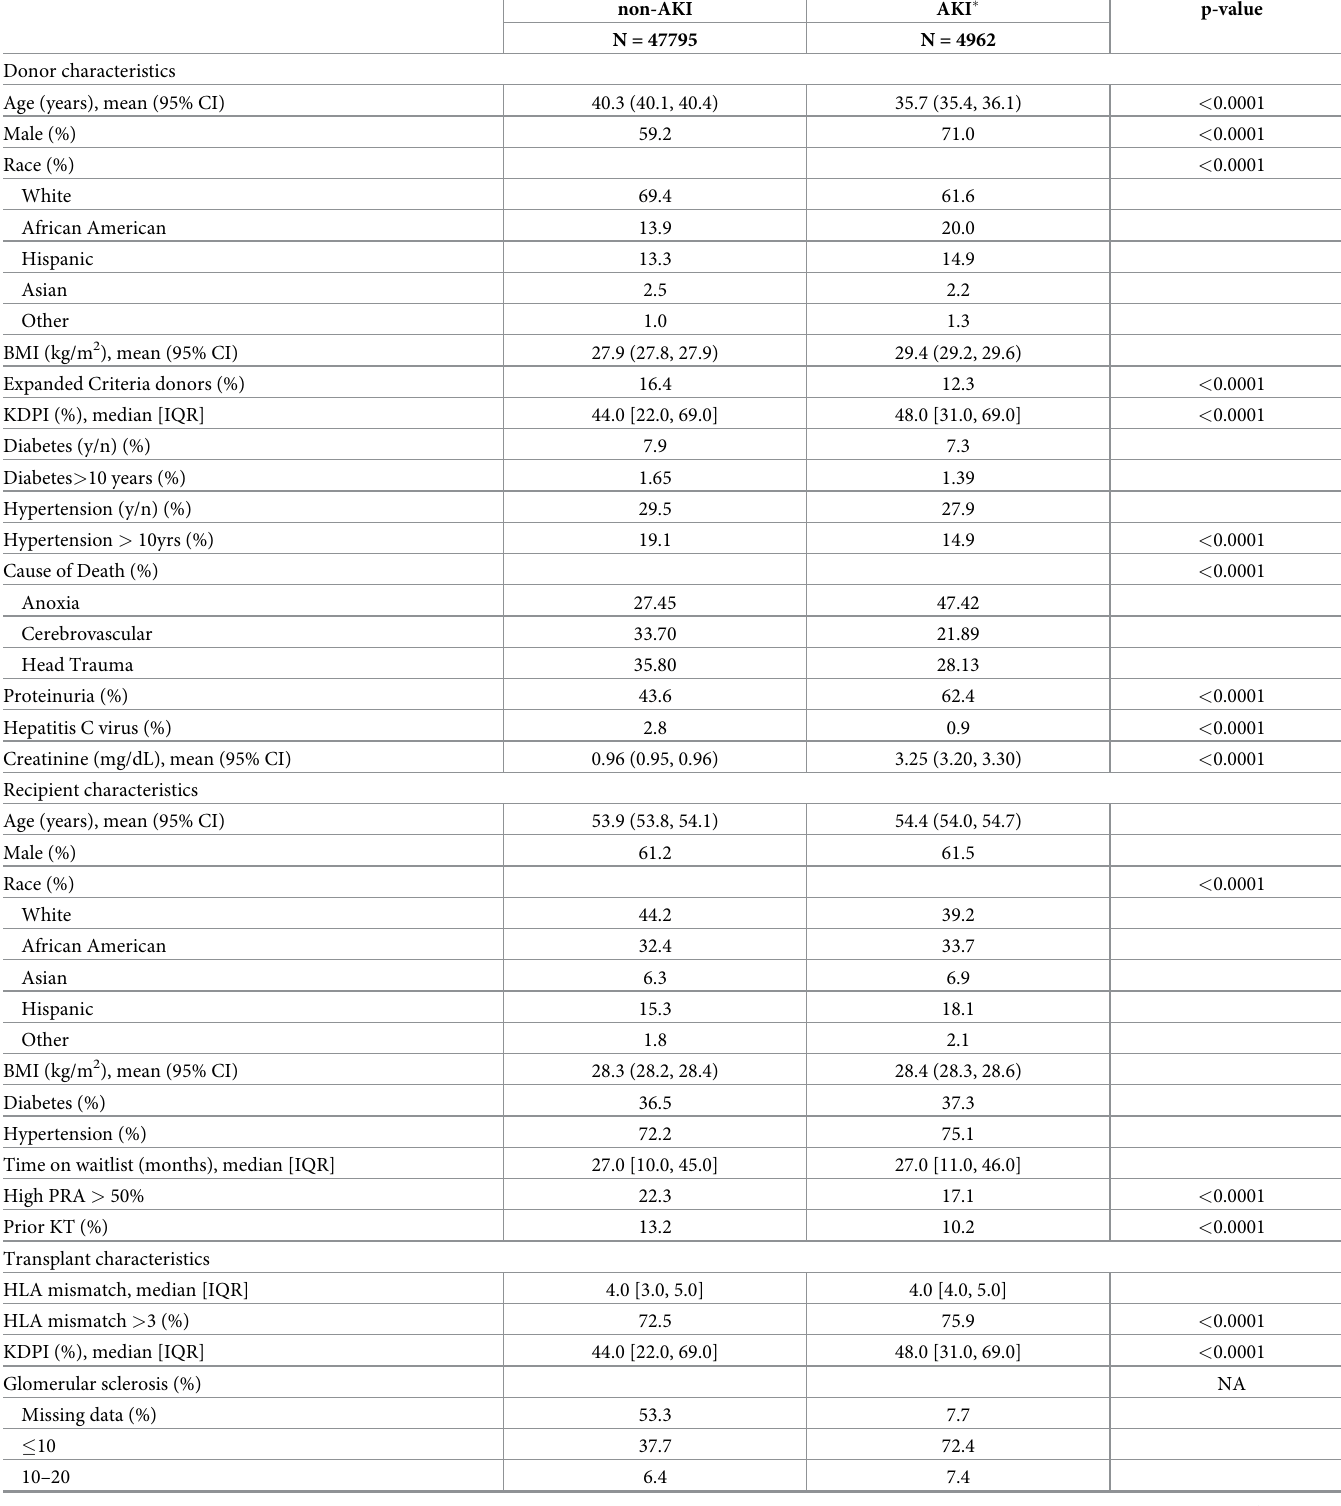
Table 1. Donor, recipient and transplant